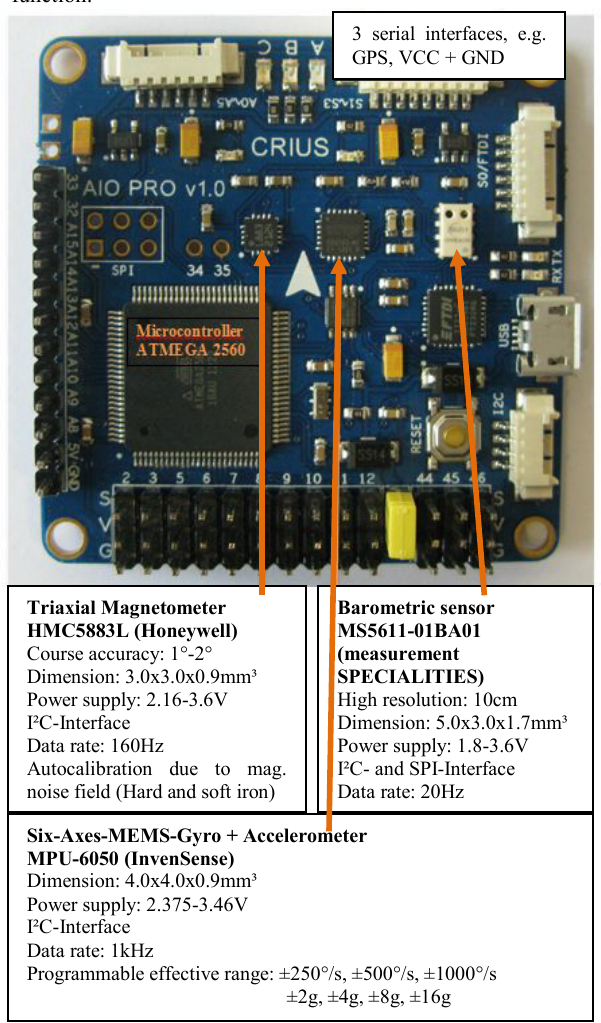
Figure 6. User interface of the real-time module RTKNAVI